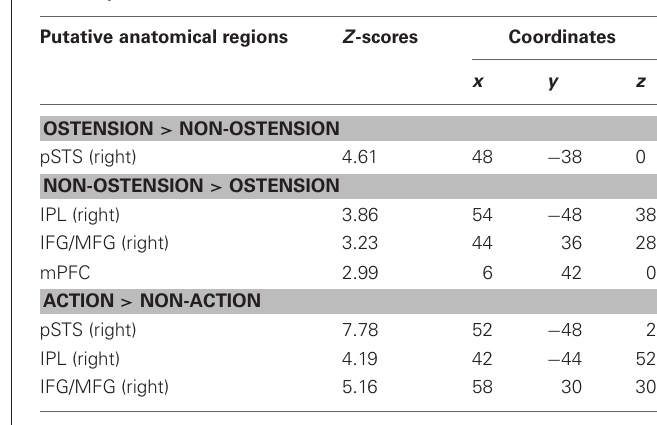
Table 1 | fMRI results (ROI analysis).